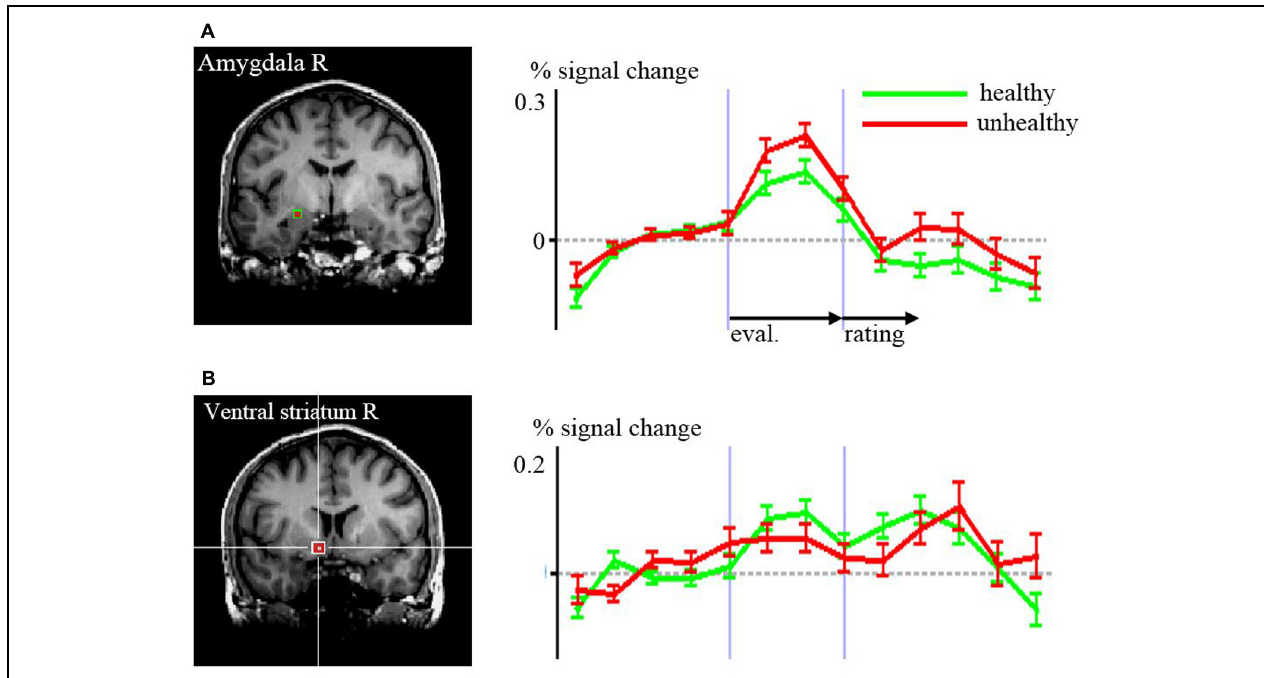
FIGURE 3 | Time courses of signal changes according to the region of interest analyses of healthy versus unhealthy food in (A) amygdala, (B) ventral striatum. The regions are indicated by the red squares in the structural MR images Differences in the time courses were significant for the evaluation (eval.) period in the amygdala ( p = 0.048) and for the rating period in the ventral striatum ( p = 0.005).